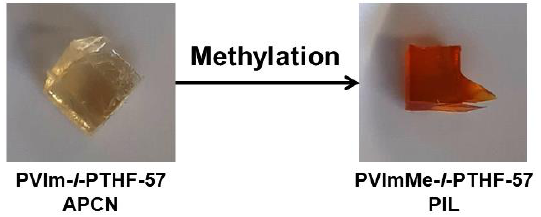
Figure 1. Pictures of the PVIm- l -PTHF conetwork before and after methylation with methyl iodide.